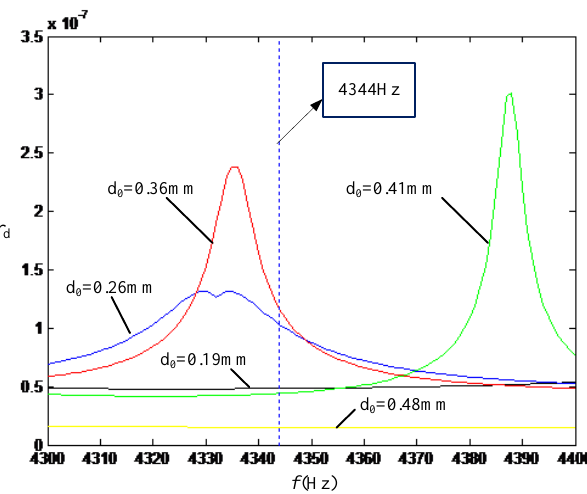
Figure 14. Variation of r d with acoustic frequency f for droplets with different initial diameters, obtained by calculation.